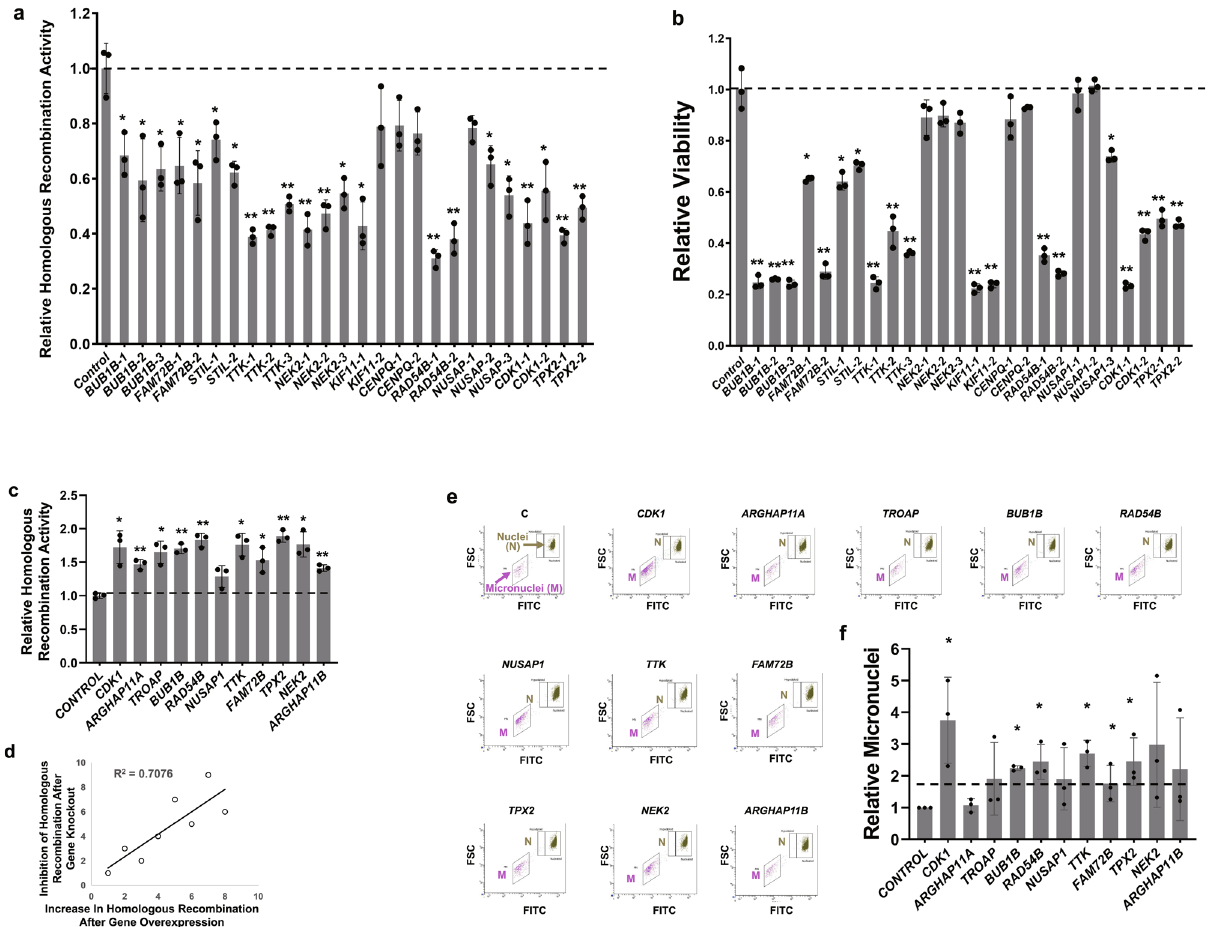
Fig. 2 Knockdown and overexpression screens evaluating GIS31 genes for impact on different aspects of genome stability and cell viability. a , b Knockdown: EAC (FLO-1) cells, stably transduced with Cas9, were treated with lentiviral single-guide RNAs, either non-targeting control or those targeting speci fi c genes (two or three guides per gene). Following selection, cells were cultured for 10 days and evaluated for impact on homologous recombination activity ( a ) and cell viability ( b ), relative to control (control bar represents average of two different control guides); error bars represent SDs of three experiments. Two-tailed p -values derived by Student ’ s t -test (* p < 0.05 – 0.001; ** p < 0.001) indicate signi fi cance of difference relative to control. c – f Overexpression: FLO-1 cells were treated with lentiviral constructs, either control or those carrying open reading frames (for overexpression) of genes, selected in puromycin, and evaluated for homologous recombination ( c ) and micronuclei (a marker of genomic instability) ( e , f ). c Bar graph showing homologous recombination activity, relative to control. Error bars represent SDs of three independent experiments. Two-tailed p -values derived by Student ’ s t -test: * p < 0.05; ** p < 0.0007; *** p < 0.00005. d The line plot shows correlation of increase in homologous recombination following overexpression vs. its inhibition following knockdown of the same set of genes (shown in a ). Note: for knockdown, the average inhibition of homologous recombination activity by all (two or three) guides for each gene was used. e Representative images showing nuclei (N) and micronuclei (MN; a marker of genomic instability) in transduced cells. X -axis is FITC signal indicating the amount of DNA in nuclei or micronuclei and Y -axis (FSC or forward scatter) indicates the size that distinguishes nuclei from micronuclei. f Bar graph showing fold change in micronuclei, relative to control cells. Error bars represent SDs of three experiments. *Two-tailed p -value derived by Student ’ s t -test <